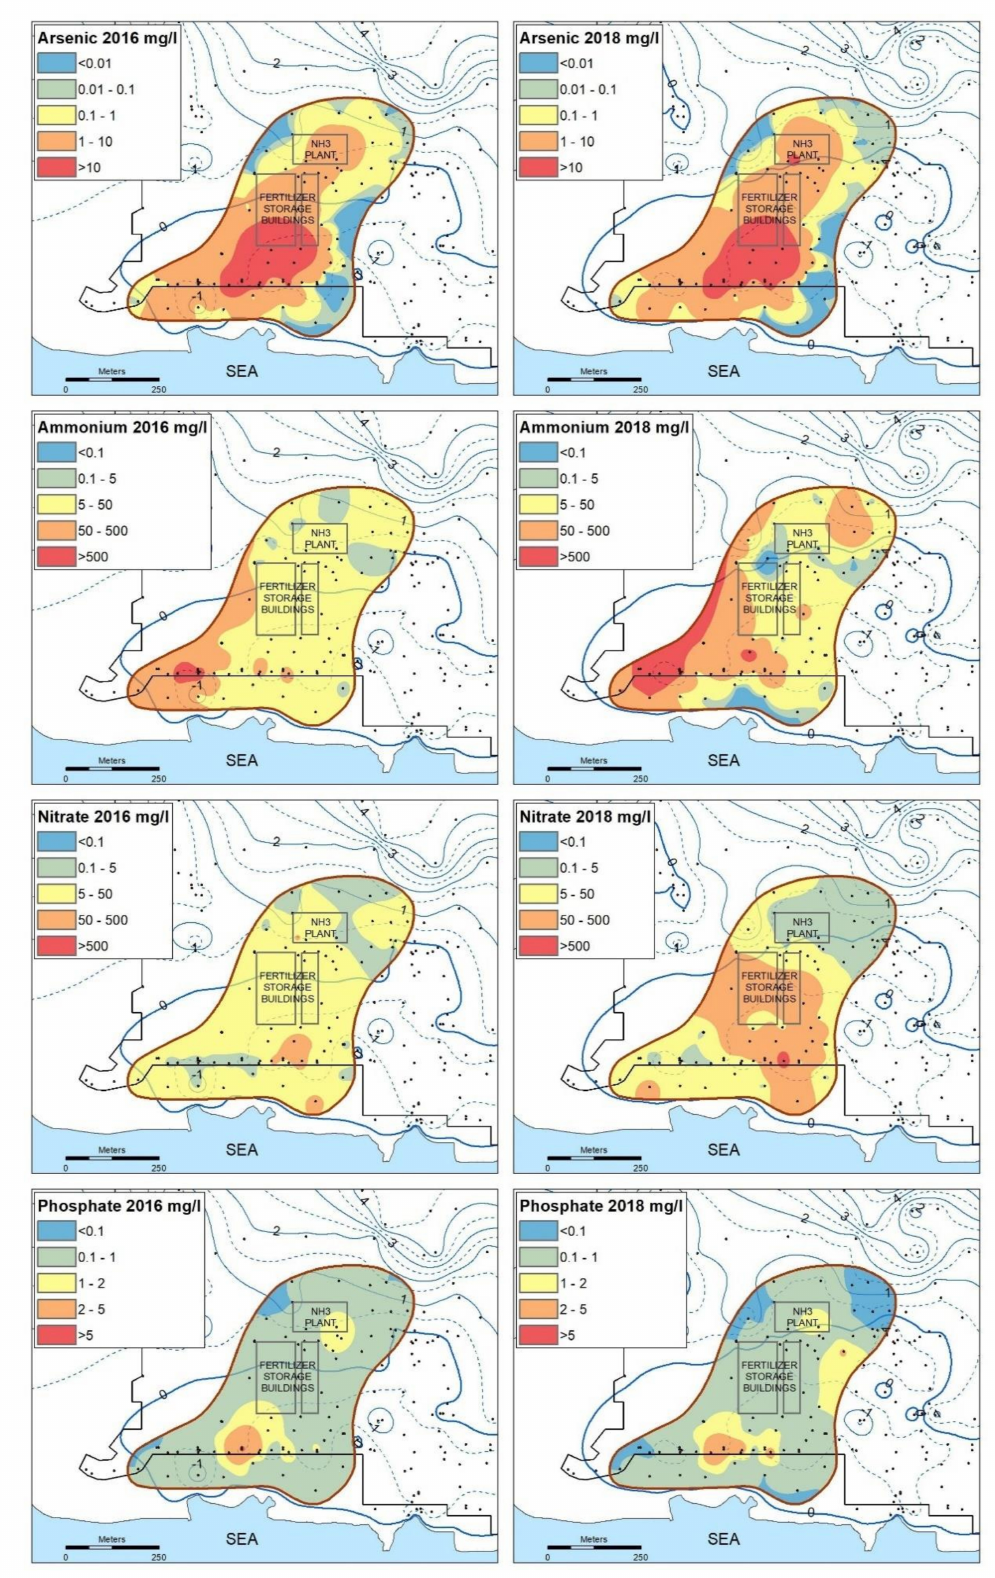
Figure 3. Iso-concentration maps of Arsenic, Ammonium, Nitrate, and Phosphate contamination in groundwater for 2016 and 2018 groundwater sampling